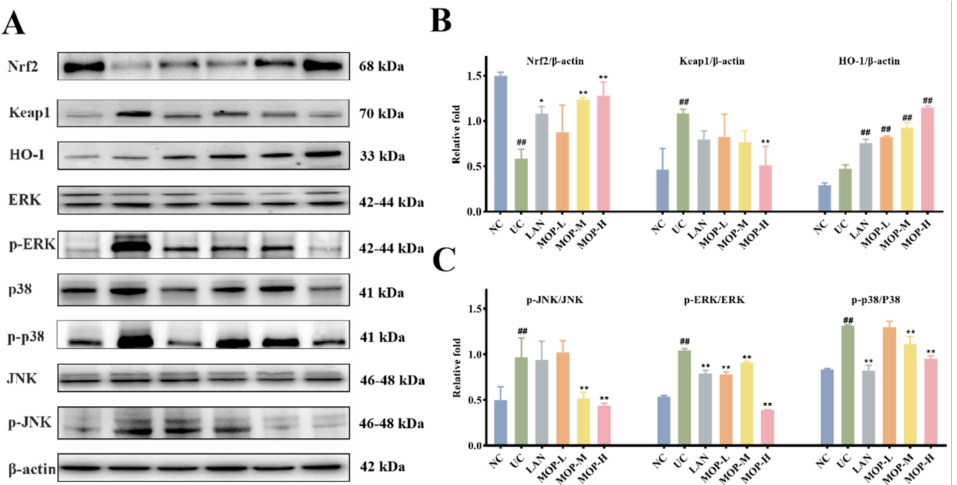
Figure 6. MOP attenuated ethanol-induced gastric mucosal injury by activating Nrf2/HO-1 and inhibiting MAPKs pathway. The western blot bands ( A ) and relative intensities of ( B ) Nrf2, Keap1 and HO-1, ( C ) p-JNK, p-ERK and p-p38. All experiments were performed in triplicate (n = 3) to determine the repeatability. # and * denotes significant differences. ## p < 0.01 vs. NC group; * p < 0.05, ** p < 0.01 vs. UC